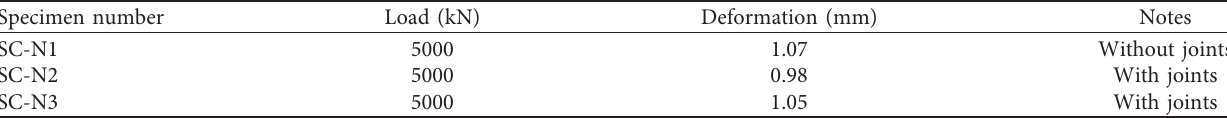
Table 3: Extreme deformation of compressive experiment